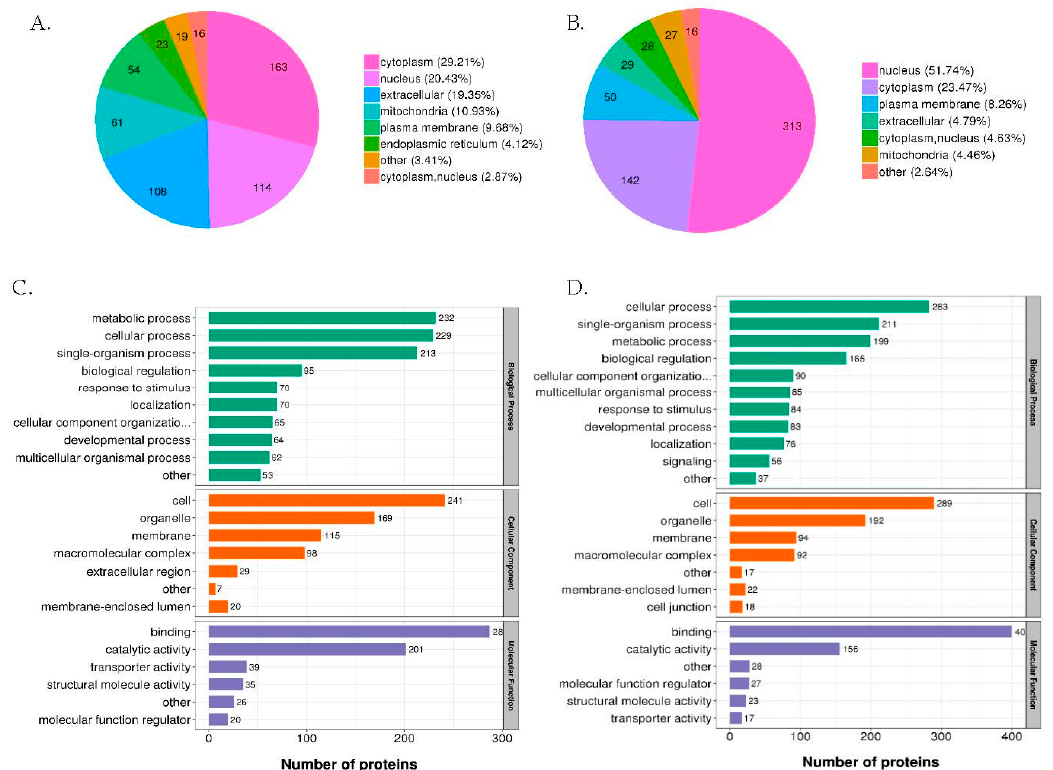
Figure 4. Functional analysis of differentially expressed proteins (DEP) and phosphoproteins (DEPP) between wild type (WT) and elovl6 − / − zebrafish. A and B. Subcellular localization charts of DEP ( A ) and DEPP ( B ). C and D. The column diagrams show GO (2nd Level) enrichment of DEP ( C ) and DEPP ( D ) in three categories (biologic process, cellular component and molecular function). elovl6 , elongation of very long chain fatty acids protein 6; GO, gene ontology.